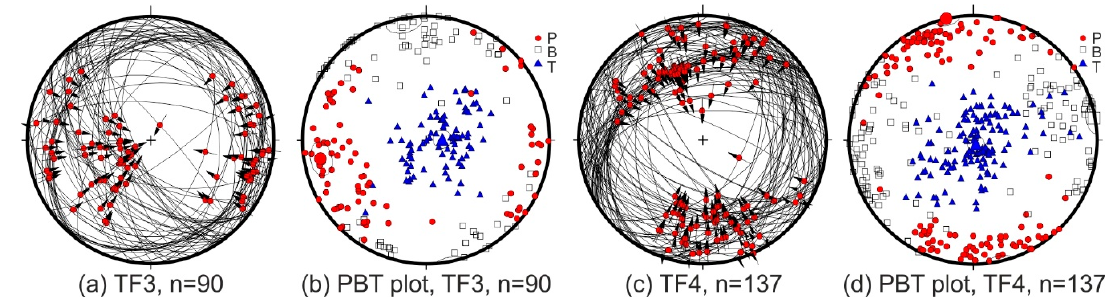
Figure 12. ( a – d ) Stereographic projections (lower hemisphere, equiareal net) and PBT plots of the total out-of-sequence thrust faults of D3 and D4 deformation stages measured in both tectonic windows. ( b ) θ = 32°; mean vectors; P: 260/15 (R = 63%); T: 349/04 (R = 66%); B: 086/80 (R = 81%). ( d ) θ = 30°; mean vectors; P: 348/00 (R = 74%); T: 080/02 (R = 64%); B: 1466/87 (R = 77%).